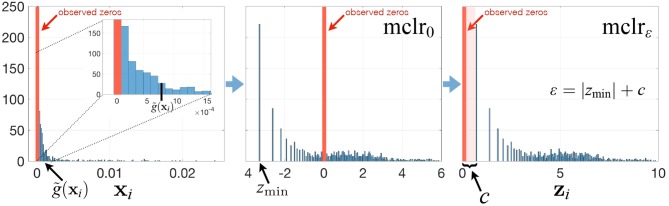
Summary of the mclrε transform for a relative abundance sample xi. See main text for a description of the different steps.